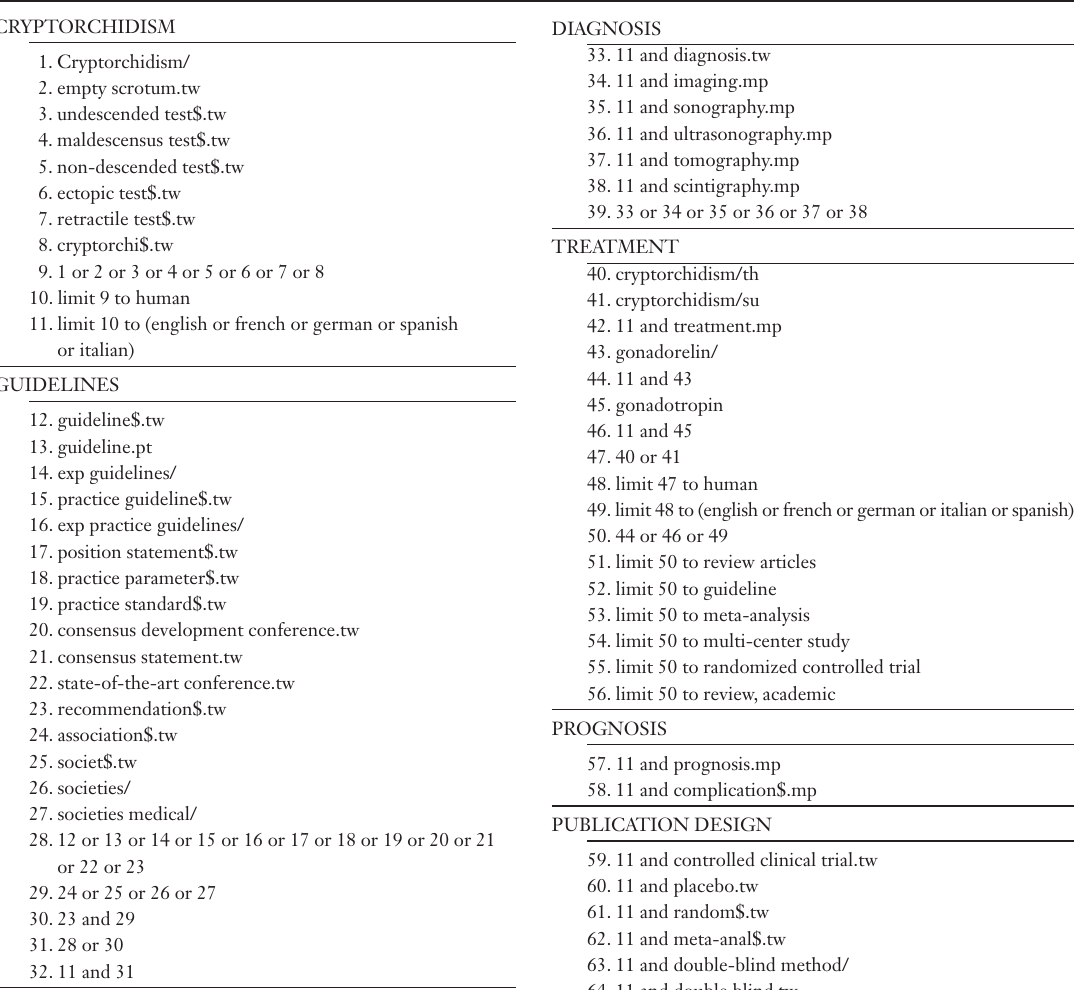
Search strategy, as used in Medline / Ovid.